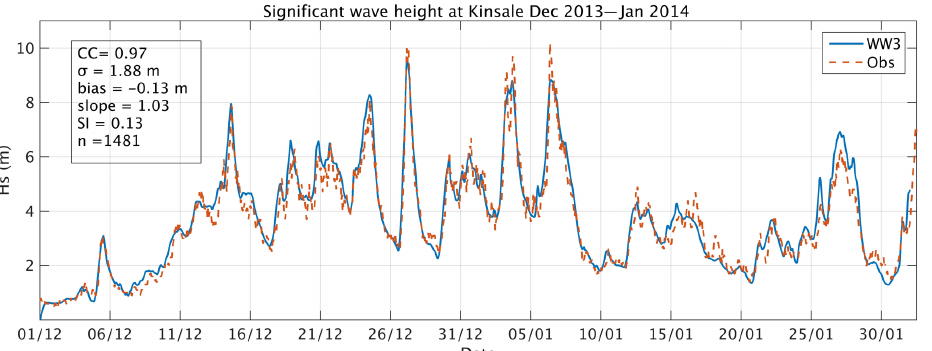
Figure 2. Timeseries of significant wave height for December 2013 comparing observations from the Kinsale Energy Gas Platform (51.37, − 7.945) radar and modelled values. In the upper left corner we provided the following statistical parameters: Correlation coefficient (CC), standard deviation ( σ ), bias, slope, scatter index (SI), and the number of records ( n ).